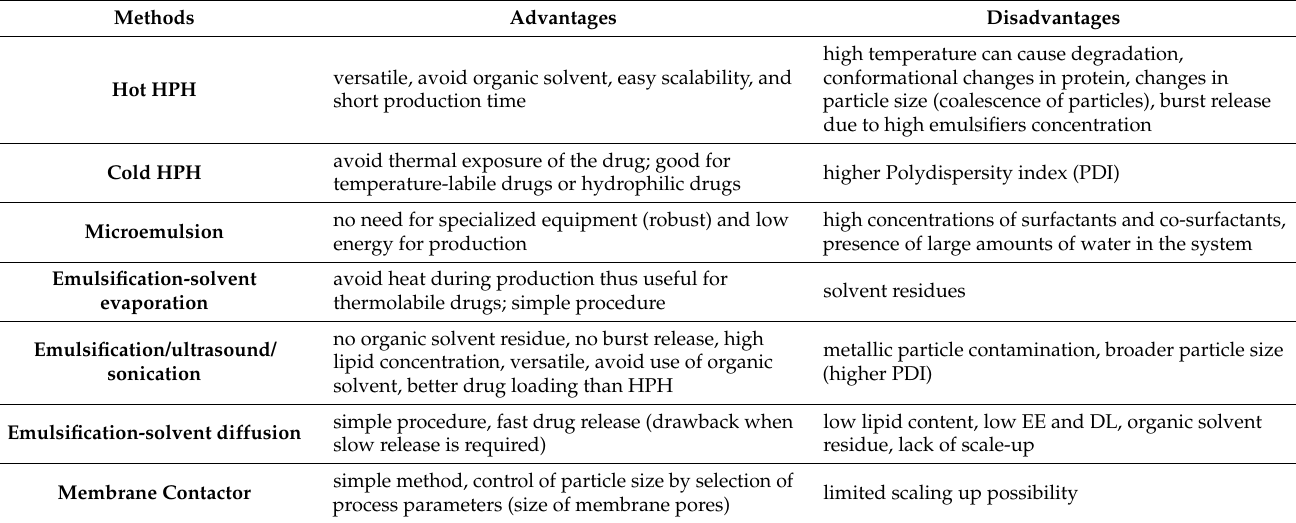
Table 5. Pros and cons of different lipid nanoparticles